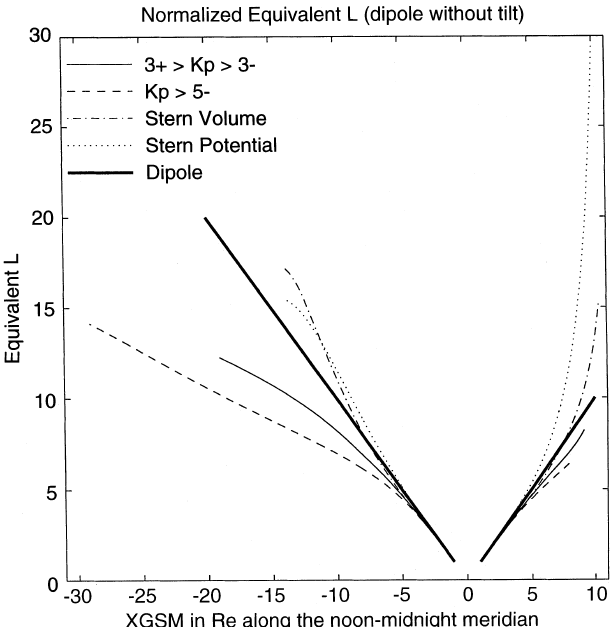
Fig. 2. Normalized equivalent L parameter as a function of XGSM in the noon-midnight meridian plane. The plain line corresponds to 3 (cid:255) < Kp < 3 (cid:135) , the dashed line to 5 (cid:255) < Kp , the dotted-dashed line to L computed from the volume # of the Stern model, the dotted line to L inferred by Stern (1967) and the bold line to the